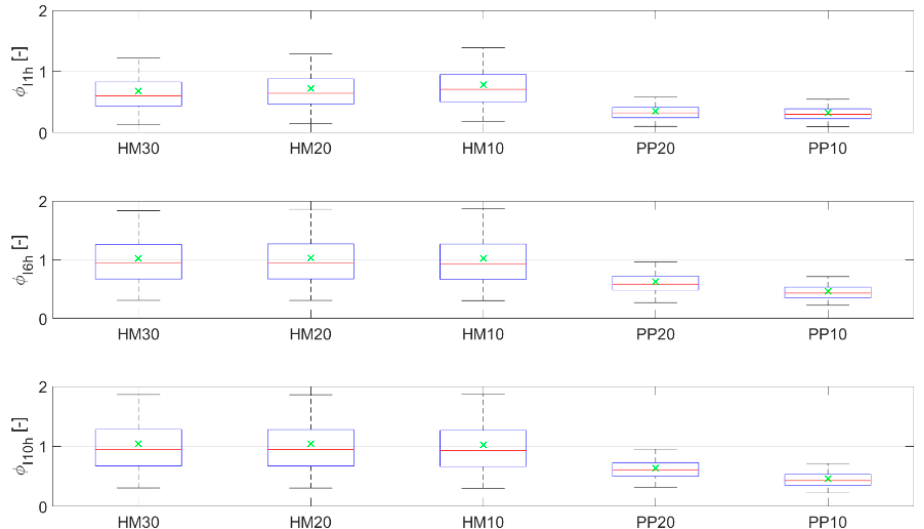
Figure 6. Boxplot of infiltration increase efficiency. In each box, the upper and lower edges indicate the first and third quartile, respectively, the red central line is the median, and the green x symbol is the mean. The whiskers length was set equal to the interquartile distance. Outliers have been hidden.